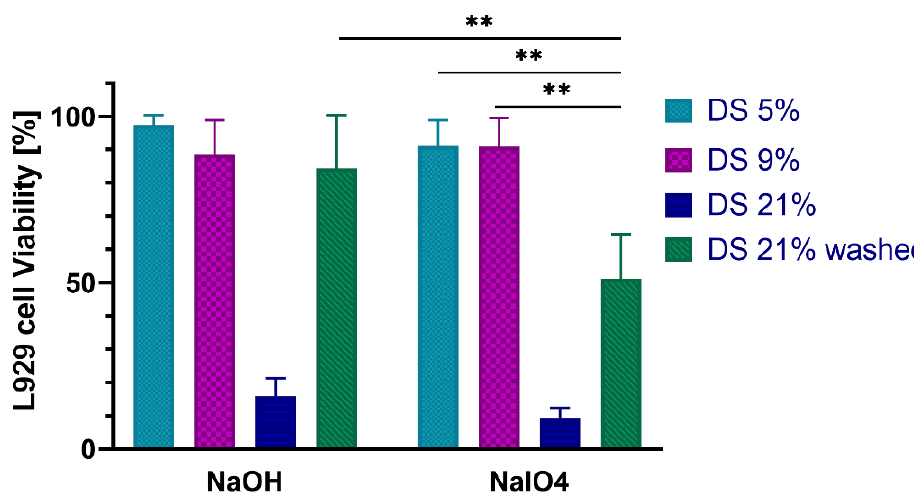
Figure 7. Viability of L929 cells after 24 h incubation with NaOH and NaIO 4 crosslinked gel extracts. n = 3, error bars = SD; ** p <